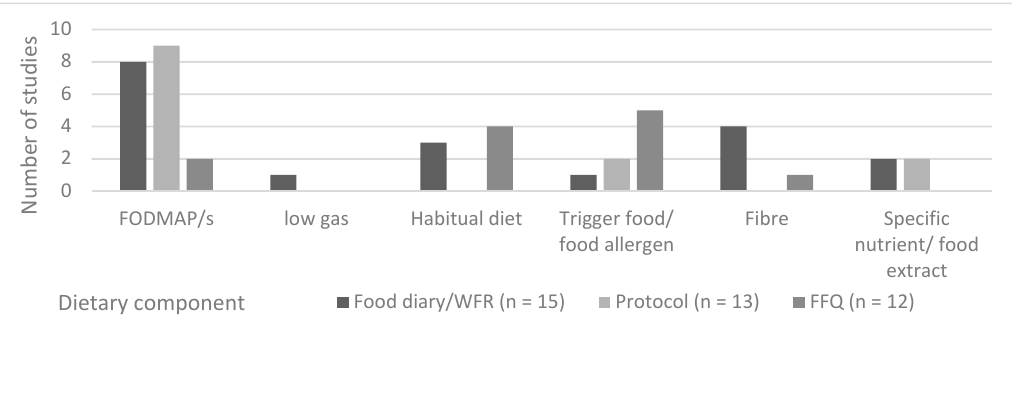
Figure 3. Dietary outcome measures by dietary assessment method in that assessed relationships between dietary intake and FGID